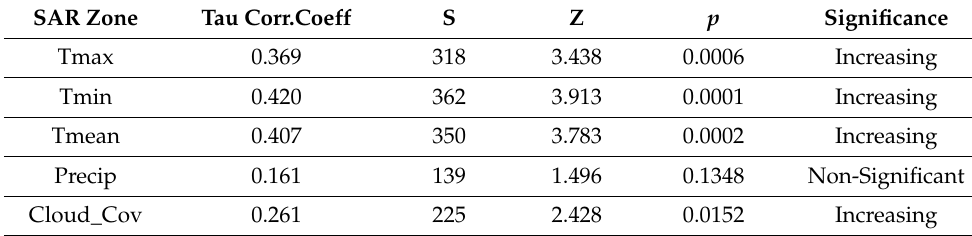
Table 8. Mann Kendall Trend Test of JJAS averaged climatic variable for SAR